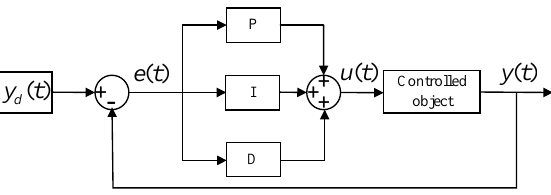
Figure 14. Principle of PID control.